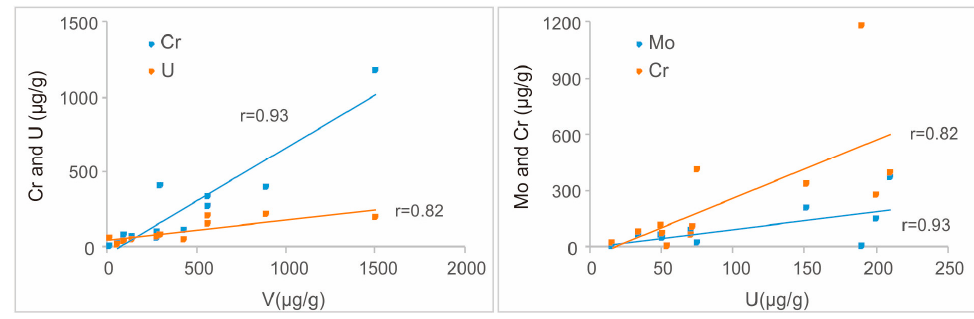
Figure 2. Correlations of V, Cr, Mo, and U.